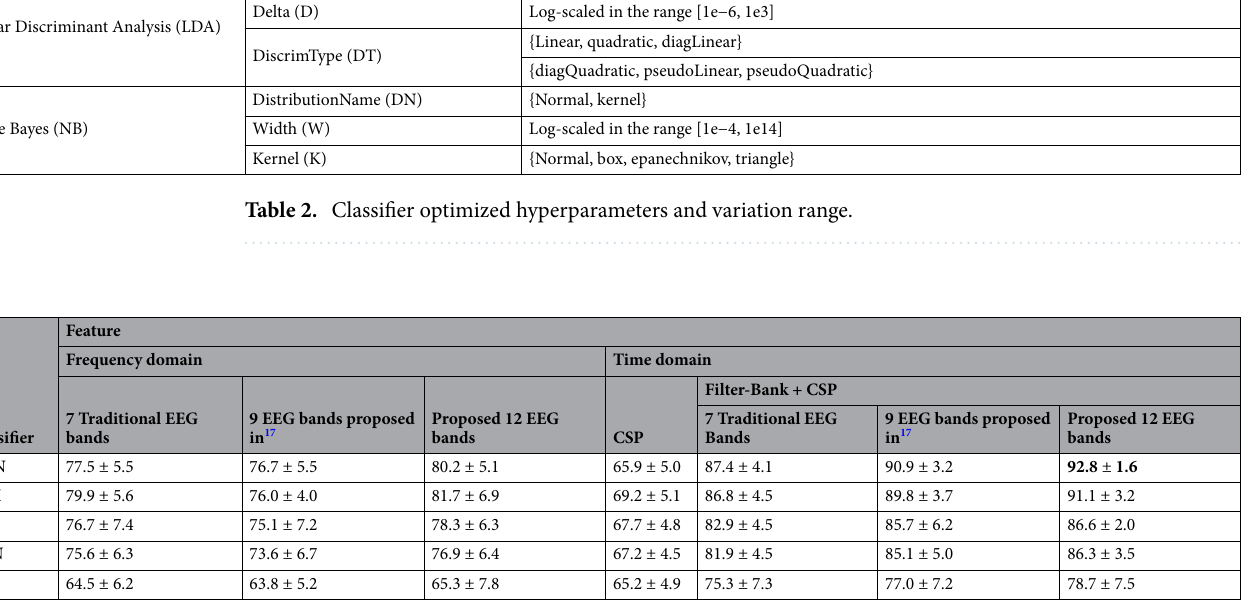
Table 3. Within-subject accuracy (mean and standard deviation percentage of the 17 subject accuracy) at varying feature and classifier. The best performance value is highlighted in